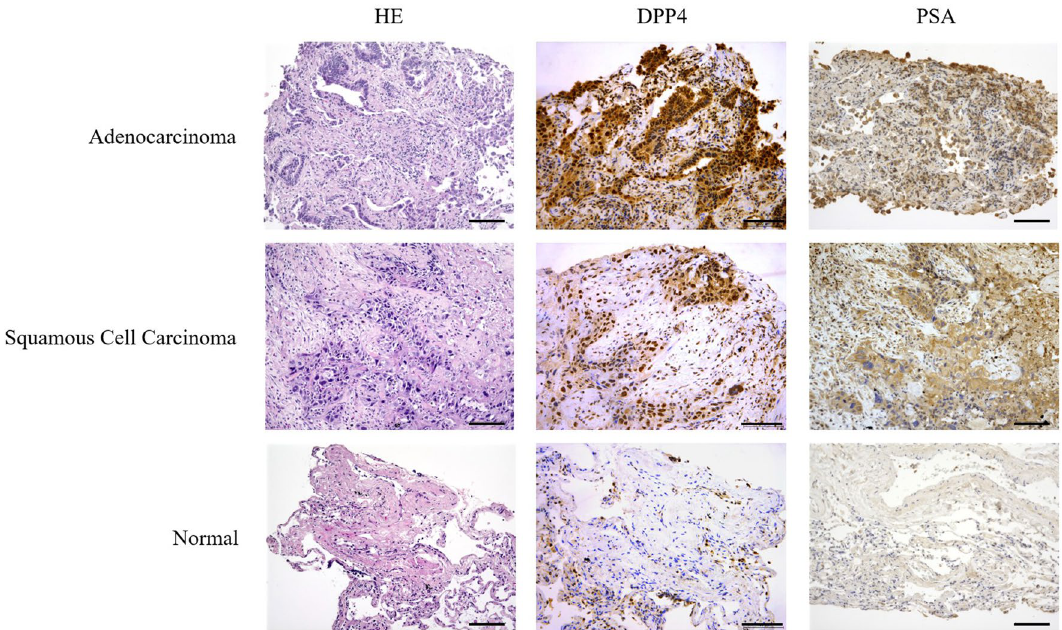
Figure 7. Pathological confirmation of the presence of DPP4 and PSA by HE staining and immunohistochemical staining of adenocarcinoma, squamous cell carcinoma and normal lung tissue. Both adenocarcinoma and squamous cell carcinoma are positive for DPP4 and PSA staining. In normal lung tissue, some macrophages and alveolar epithelium were positive for DPP4, but others were negative. PSA was negative in all normal